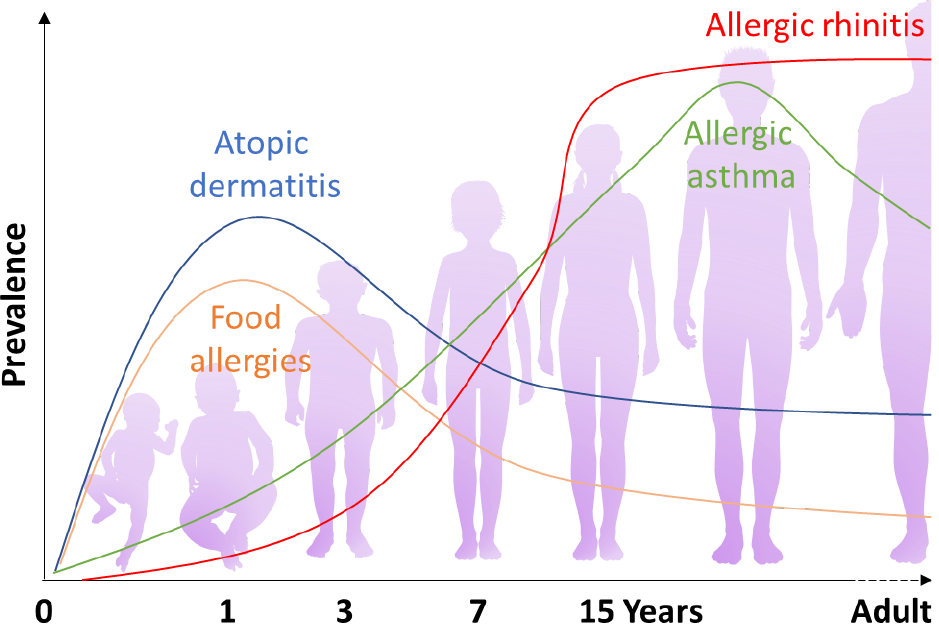
Figure 1. Schematic representation of the prevalence of the different conditions that constitute the atopic march over time. Atopic dermatitis and IgE-mediated food allergies are generally the first to develop early on during infancy. Allergic asthma and allergic rhinitis often follow, appearing later on during childhood.